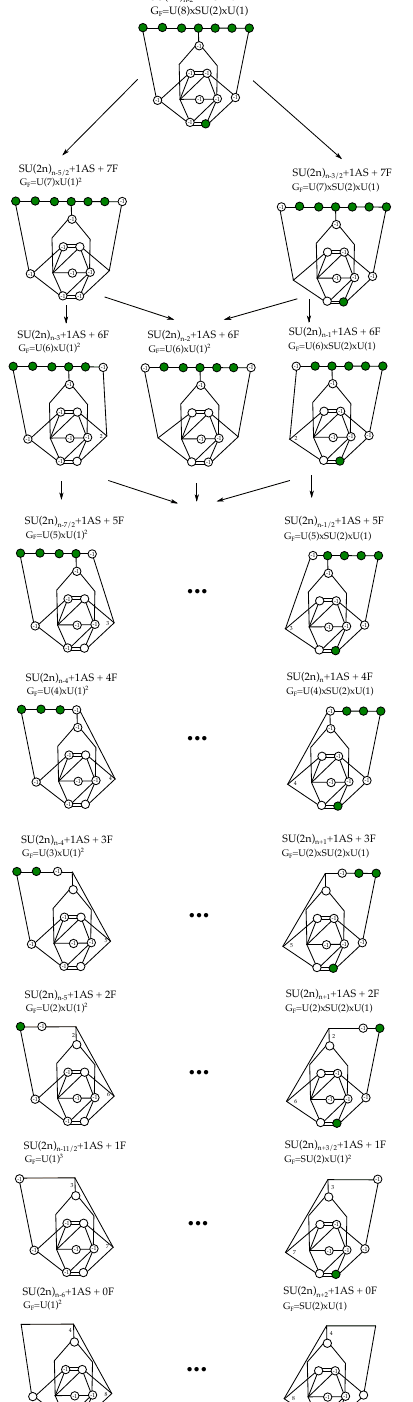
Figure 21. Sub-trees of the CFD-tree (cid:12)gure 19: SU(2 n ) 0 + 1 AS + N f F , N f (cid:20) 7 decoupling the fundamental (cid:13)avors results in the sub-tree shown in this (cid:12)gure. The enhancements are consistent with the